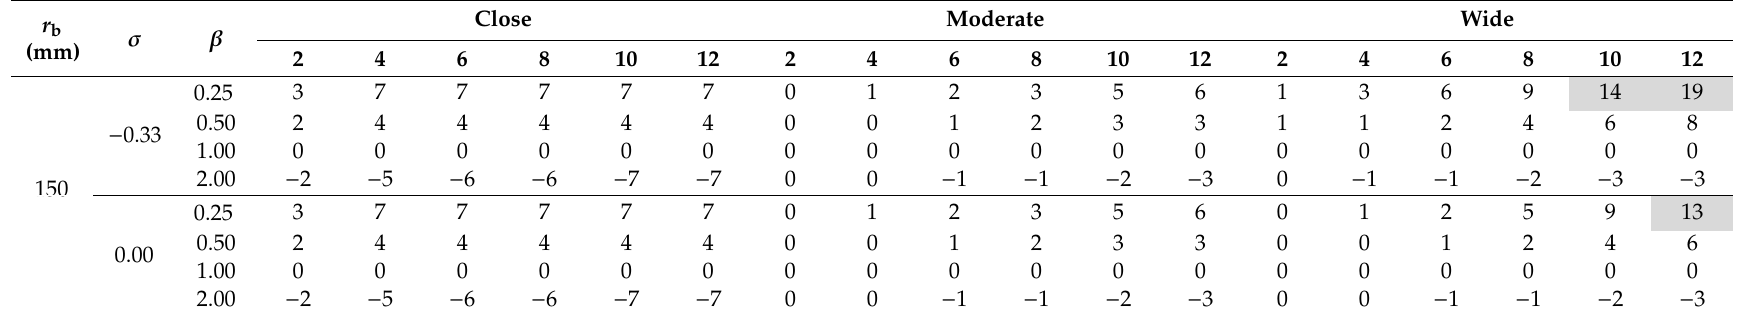
Table 2. Relative error ∆ R b0 ( N , r b , r c , r p , σ , β ) in percent for N = 2 to 12, and r c = r c,min (close spacing), 2 r b / 3 (moderate spacing), and r b − r p (wide spacing) a . The pipe radius r p is 0.0125